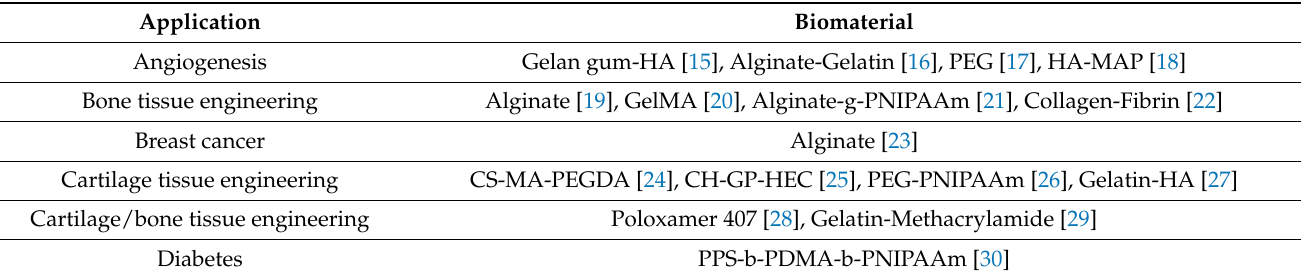
Table 1. Natural and synthetic encapsulation biomaterials utilized in various medical applications.